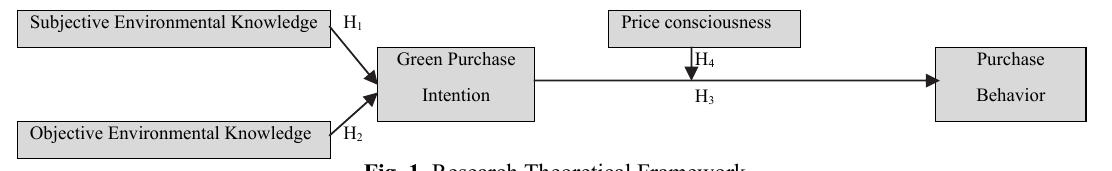
Fig. 1. Research Theoretical